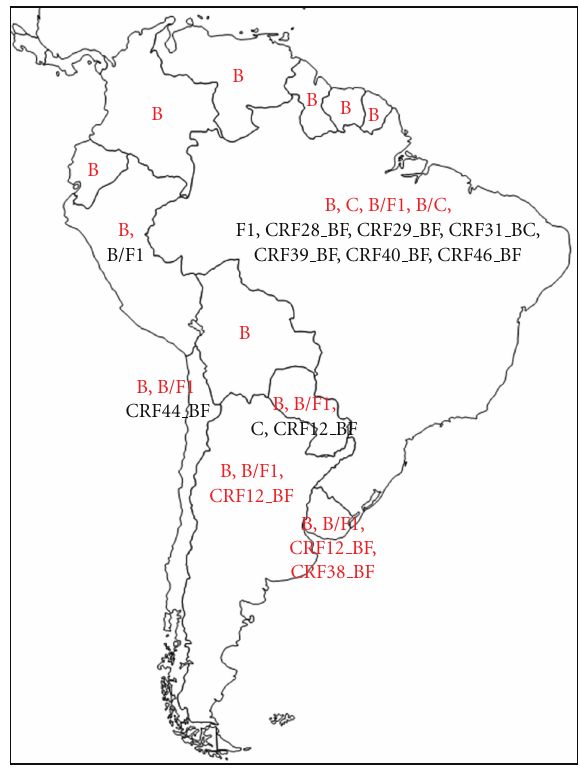
Figure 1: Political map of South America depicting the major HIV- 1 variants occurring in each country. Major variants (prevalence above 5%) are listed in